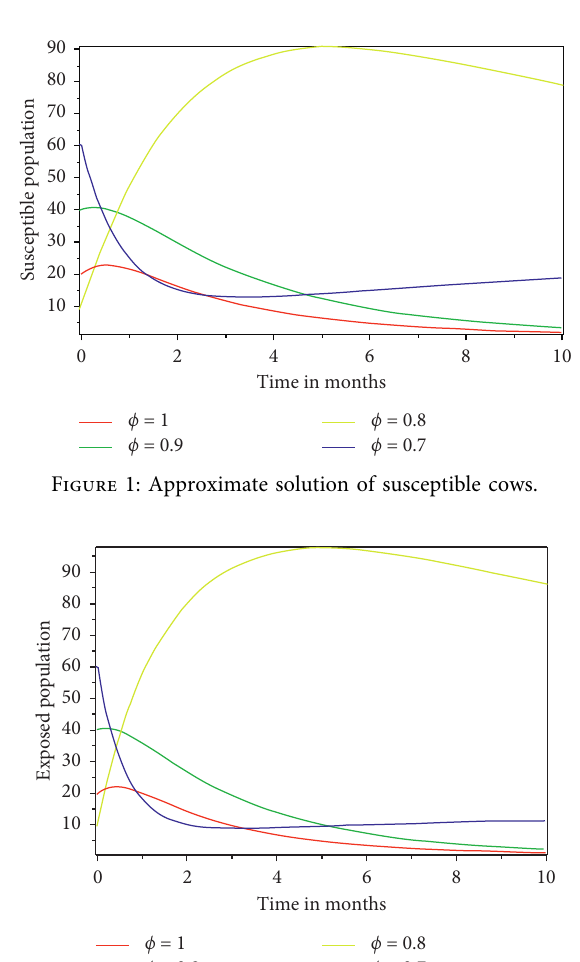
Figure 5: Approximate solution of susceptible cows for ϕ � 1.